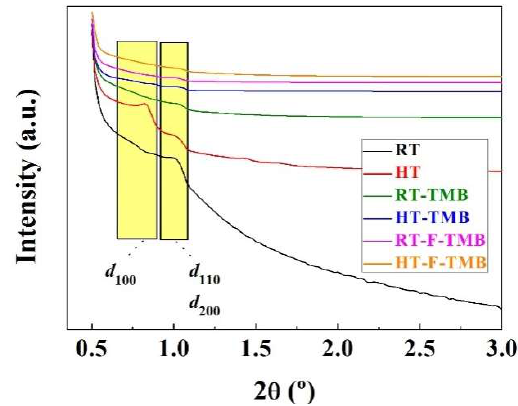
Figure 1. Small-angle X-ray scattering (SAXS) pattern of the Zr-doped silicas.